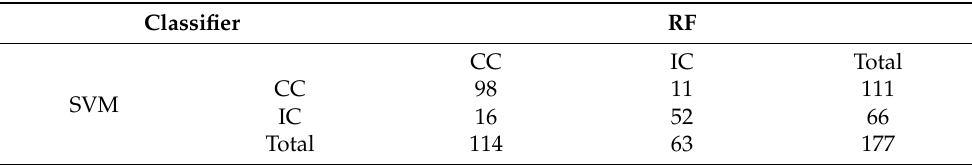
oversampling and undersampling